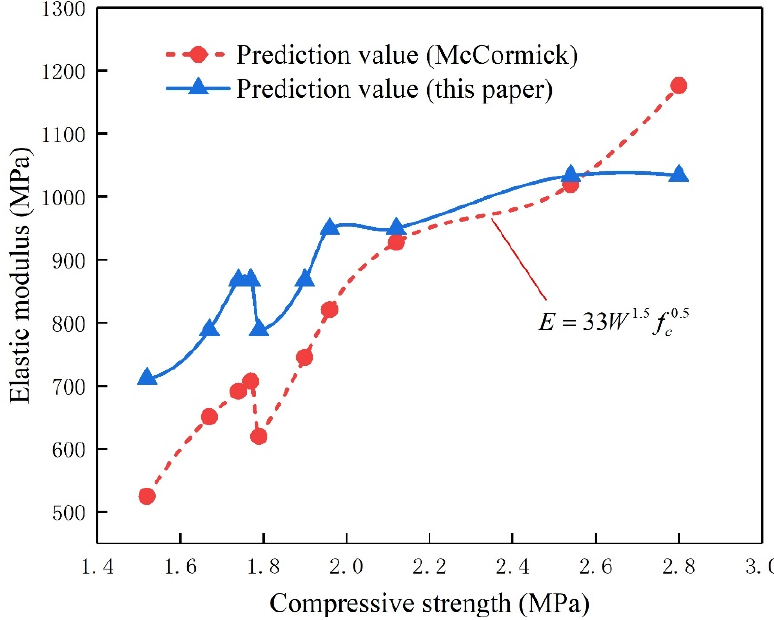
Figure 11. Comparison of elastic modulus theory of foamed concrete and existing research (McCormick [31]).